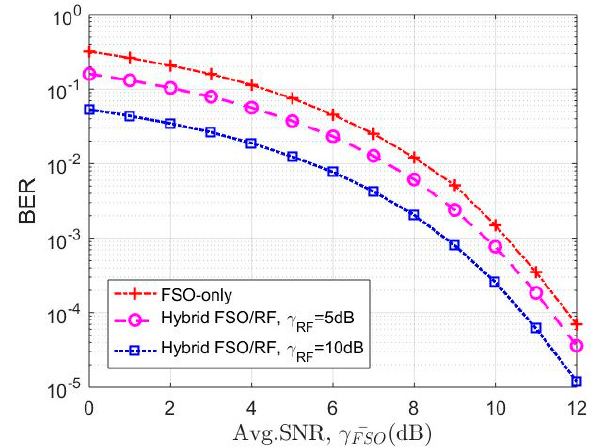
Figure 4. Bit error rate as a function of average SNR of FSO link.